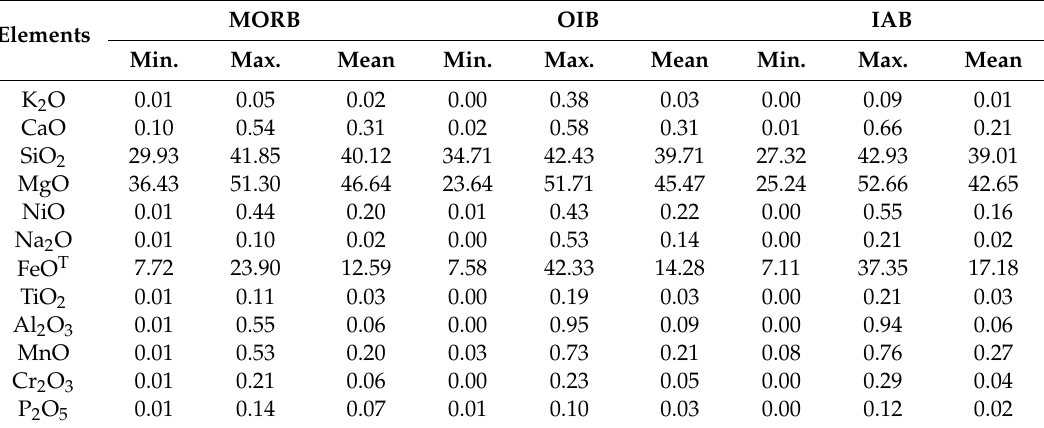
Table 3. Basic statistics for dataset 2 with low-dimensional